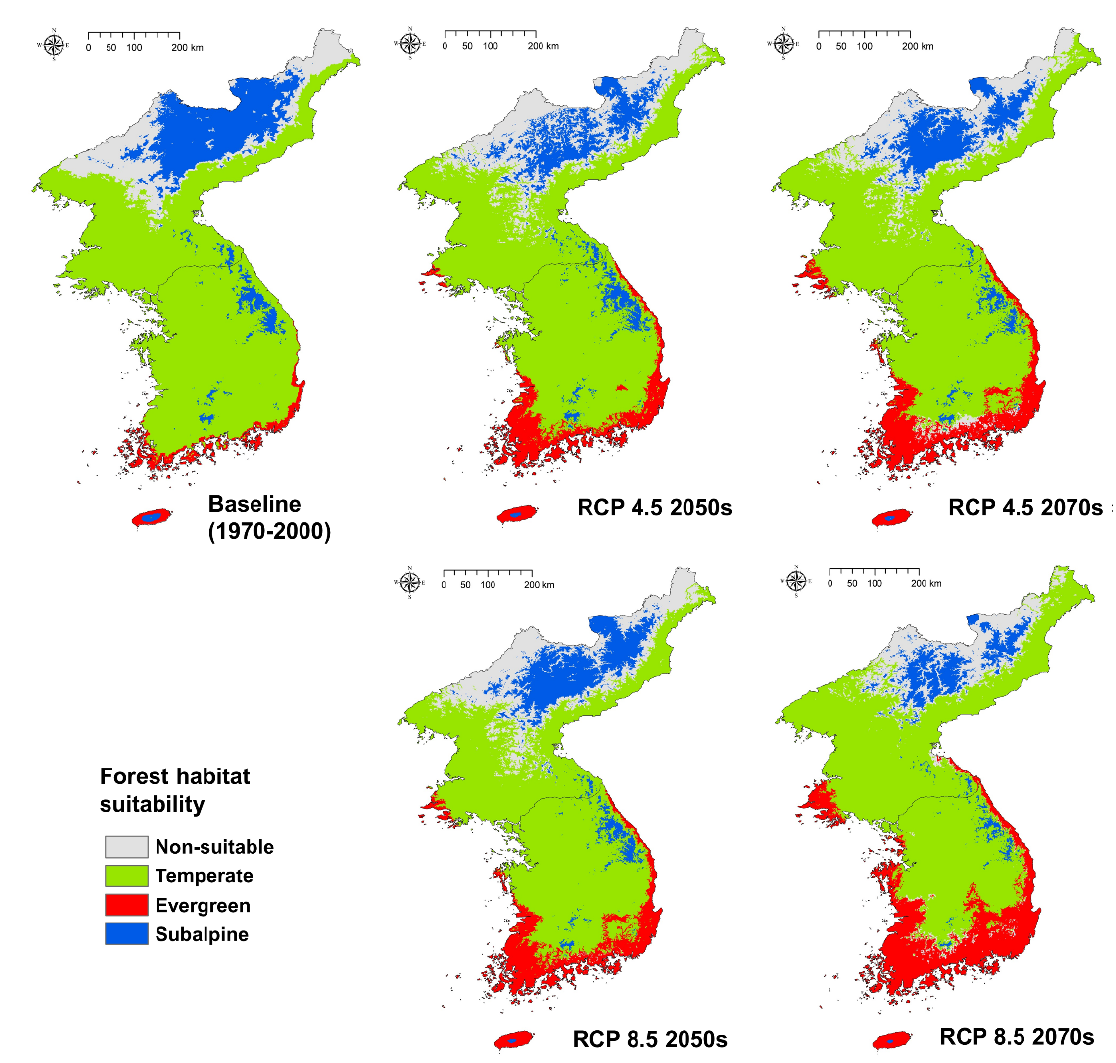
Figure 6. Spatial distribution of forest habitat suitability in baseline and future climates.